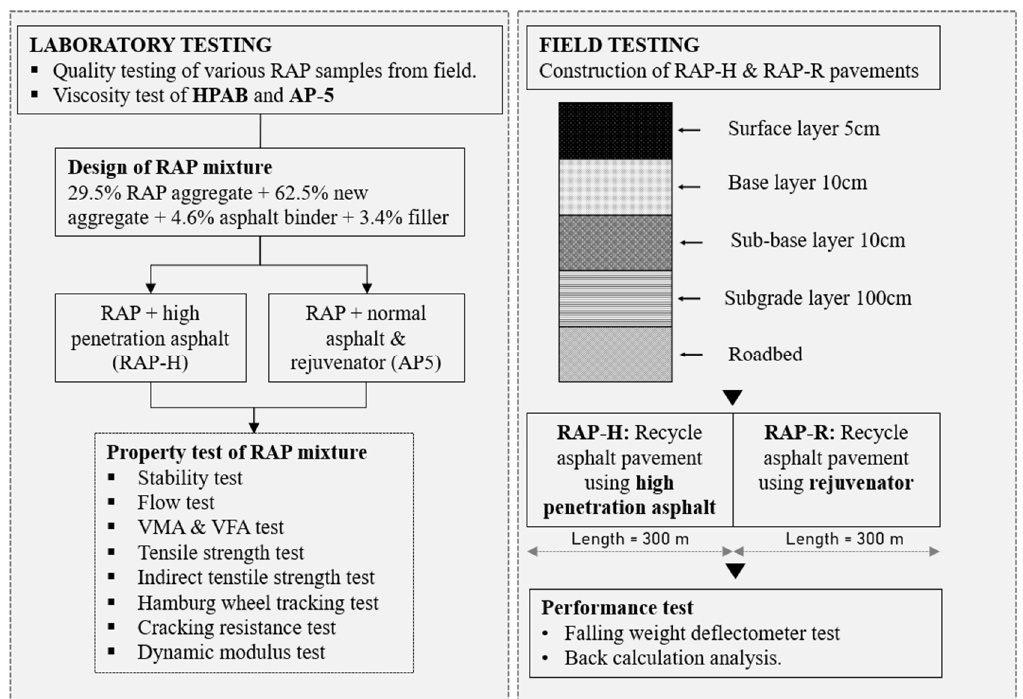
Figure 3. Design of research method.